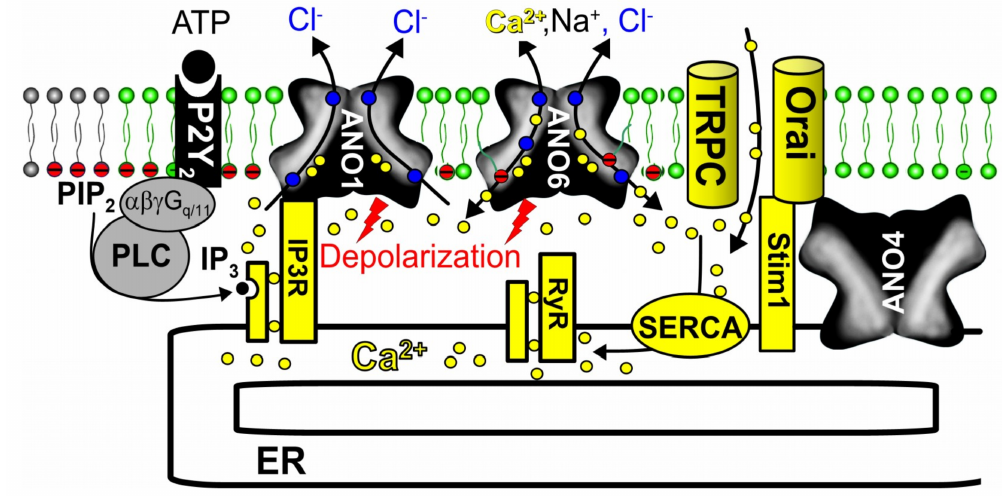
Figure 4. Compartmentalized Ca 2+ signaling by anoctamins. Scheme illustrating the effects of anoctamins on Ca 2+ signaling. ANO1 tethers ER Ca 2+ stores close to the plasma membrane, which leads to improved ATP-induced apical Ca 2+ signaling. Activation of both ANO1 and ANO6 induce plasma membrane depolarization, supporting release of Ca 2+ from ER stores via inositol trisphosphate receptors (IP 3 R) and ryanodine receptors (RyR). In addition, Ca 2+ store content was found to be enhanced by ANO1. ANO6 is permeable for Ca 2+ and therefore supports Ca 2+ entry. ANO4 localized in the ER interacts with Orai1 [110]. For further details and references, see main